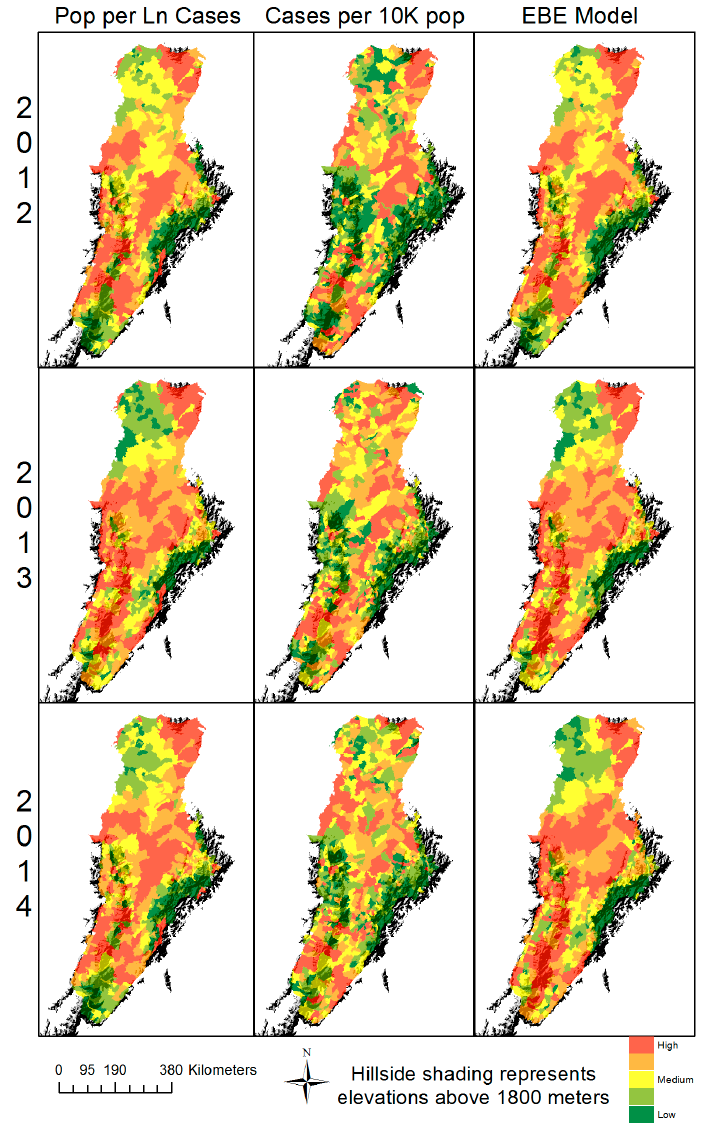
Figure 4. Population density and EBE model graphical comparisons to the reported cases per 10,000 population.